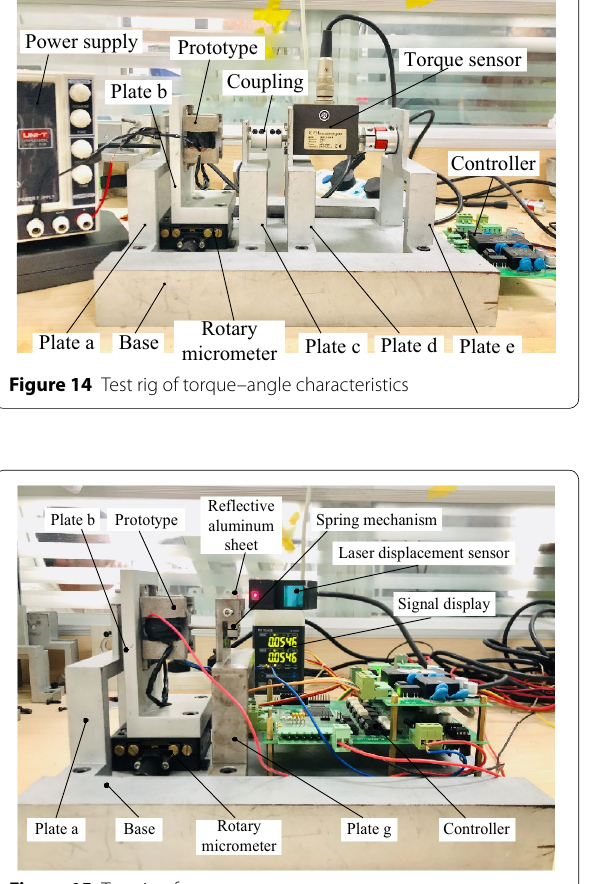
Figure 15 Test rig of step